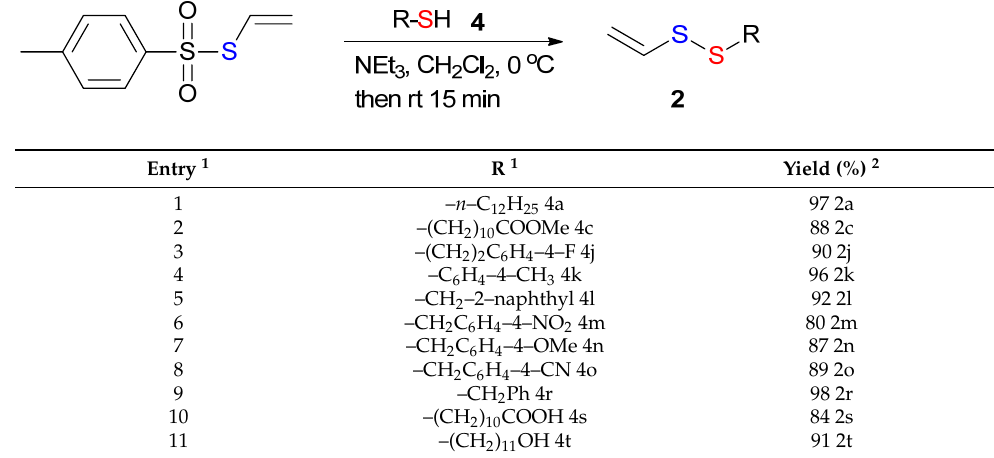
Table 2. Synthesis of vinyl disulfides 2 from S -vinyl thiotosylate.